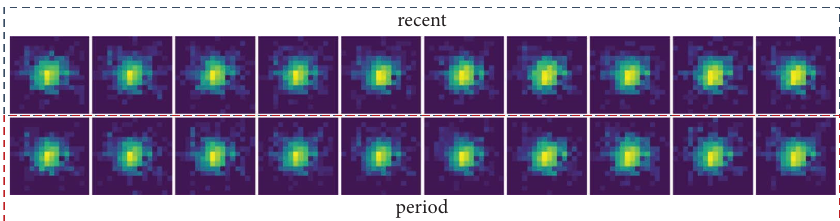
Figure 7: Te visualization of the sampled input data.